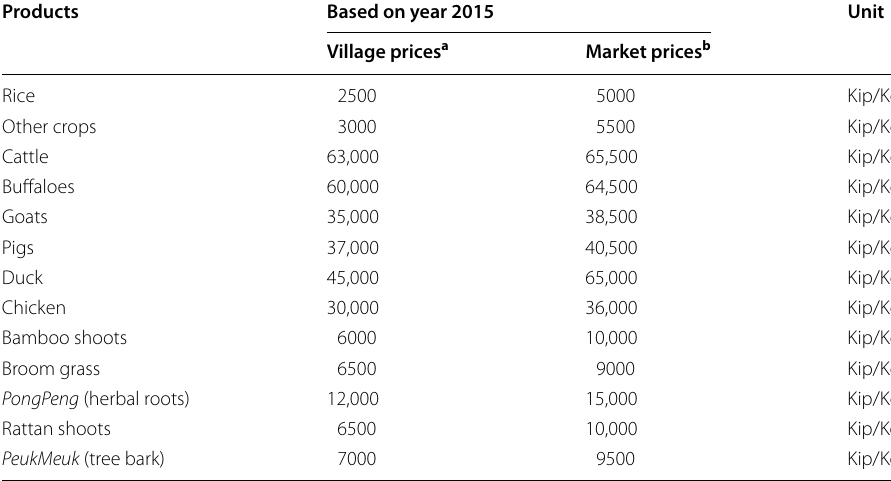
Table 3 Prices of each product in the targeted village (2015). Source: Household Survey Data (Phonxay Village Office), March 8, 2016